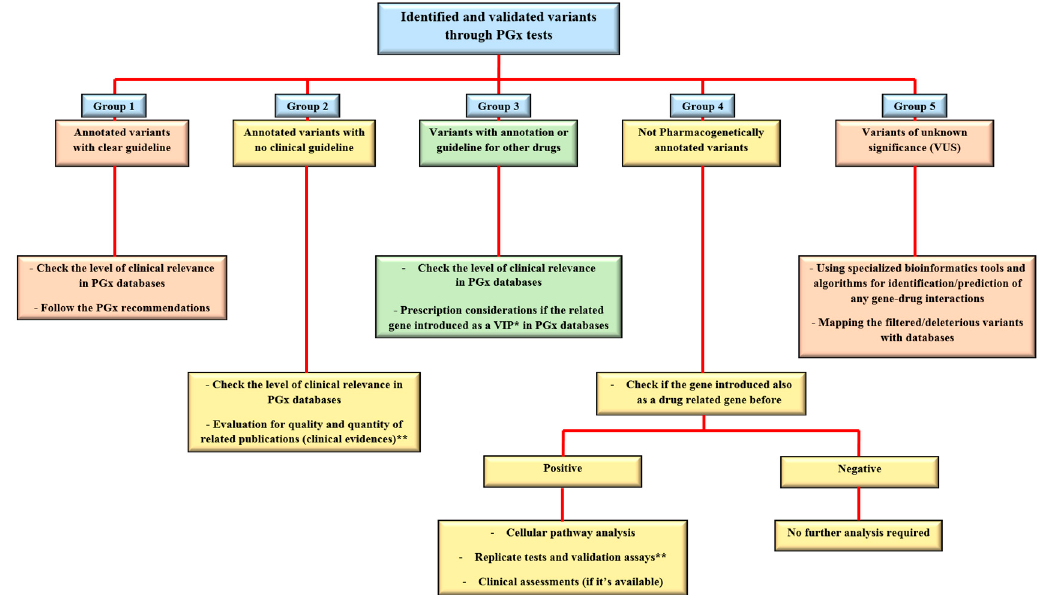
Figure 1. Approaches to deal with different types of PGx variants in clinical centers. After the identification and doing the confirmation tests on a PGx related variant, it could be categorized in one of the main five groups of annotated with PGx guideline, annotated without a guideline, informative for other drugs, not PGx annotated, or variants of unknown clinical significance (VUS). For the annotated variants, checking the level of clinical relevance (Table 1 of the current paper) is the first task to do. Bioinformatics tools are also supporting the analysis of not only VUS but also other types of variants in each group. Examples for groups 1–5 with explanations are provided in the main text. * VIP: very important pharmacogene. ** see the text for more